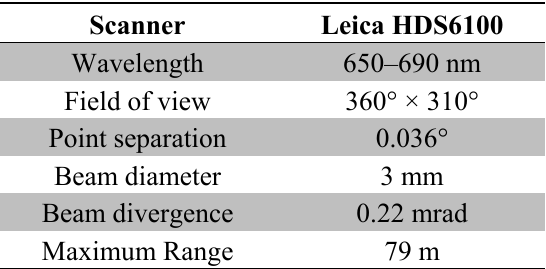
Table 1. Terrestrial laser scanner parameters.